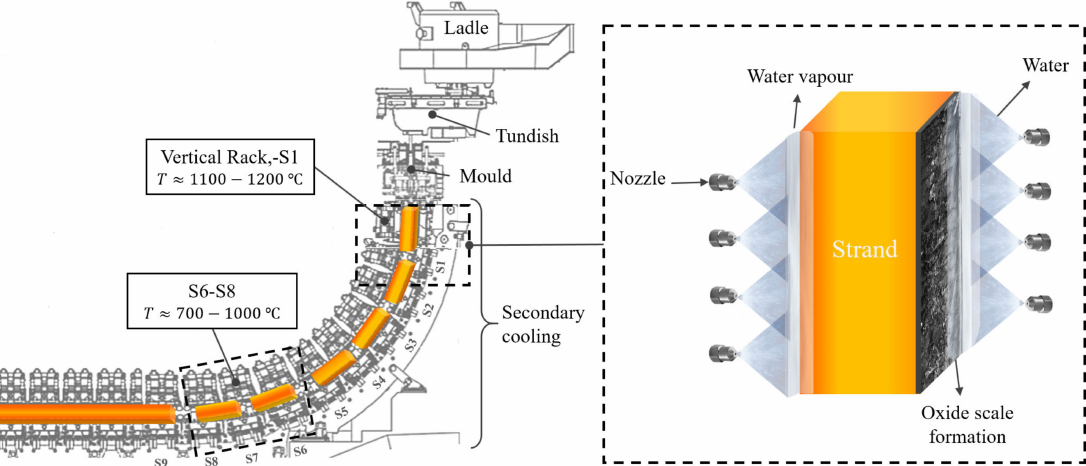
Figure 1. Layout of a continuous casting machine indicating zones and temperatures used for the experimental set-up to simulate oxidation in the water vapor condition for a high strength low alloy (HSLA)